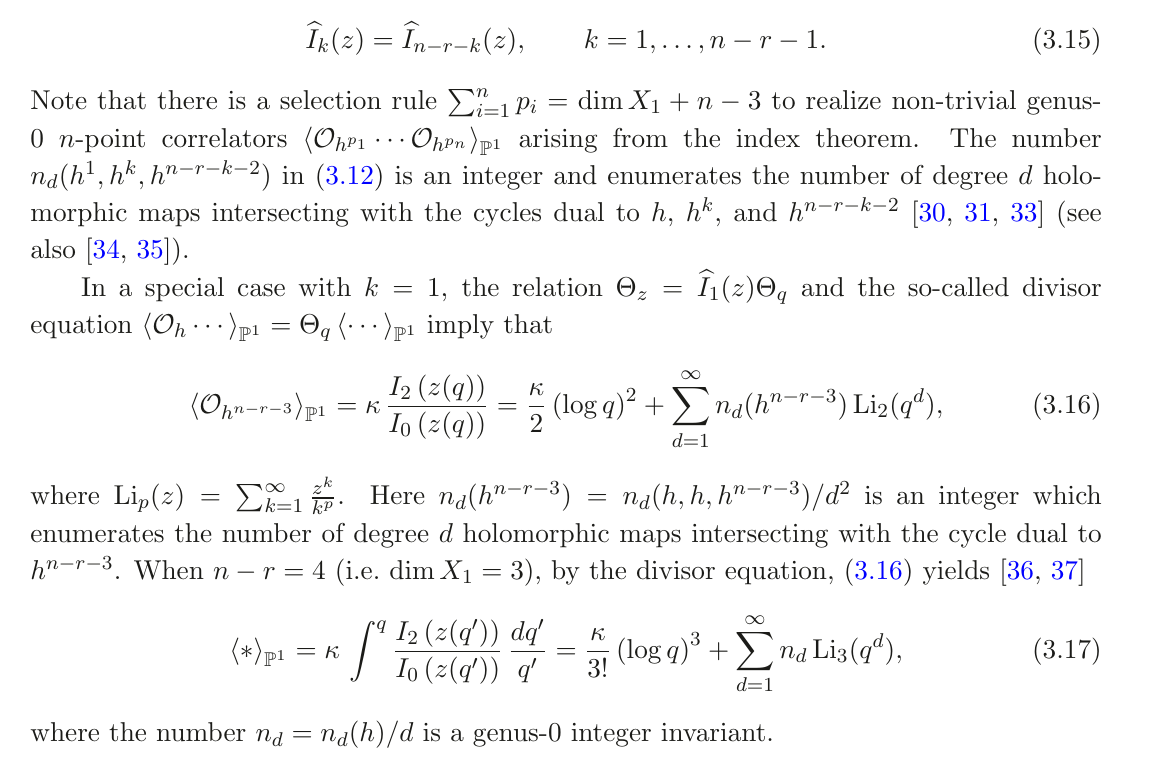
is the classical intersection number of X 1